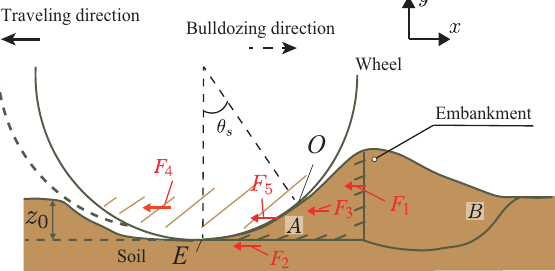
Figure 3. Locked-wheel on the soil surface based on Wong’s observation [6]. The soil wedge (area A ) beneath the wheel is assumed to move together with the wheel. The surface between soil wedge areas A and B is assumed as a virtual